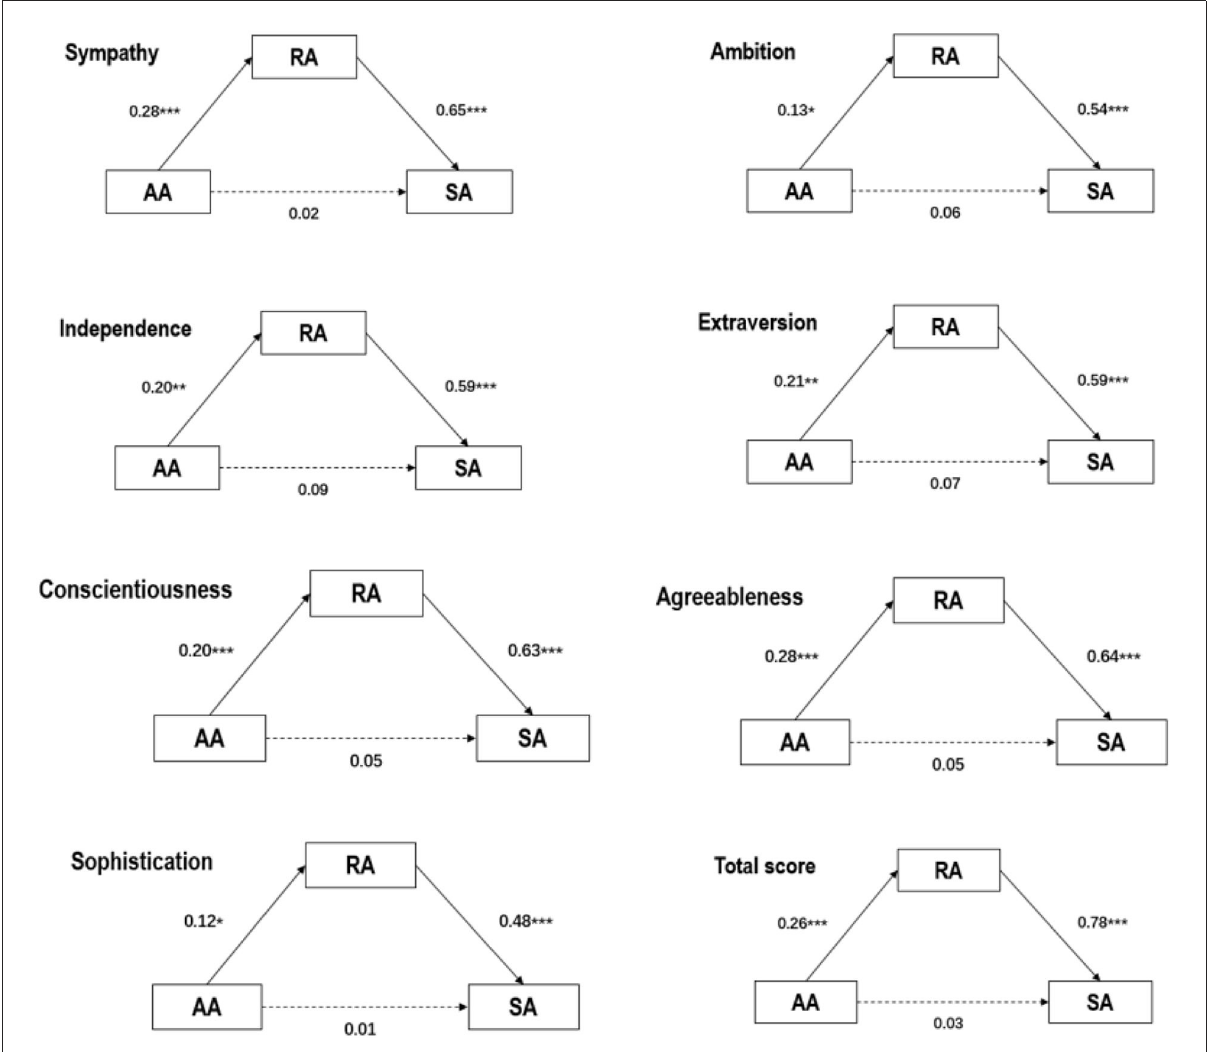
FIGURE1 Mediation models of the effect of peers’ actual appraisals and self-appraisals via peers’ reflected